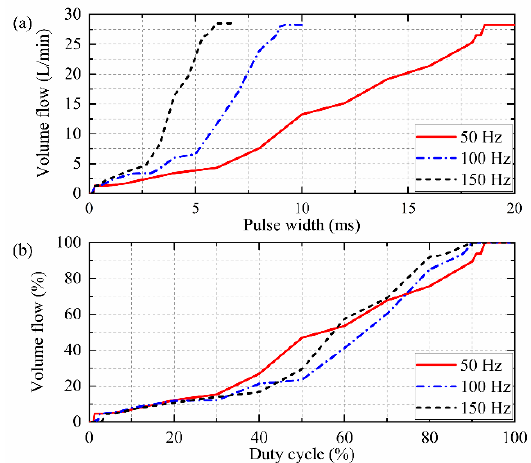
Figure 3. Standard and normalized results from 0.01 MPa pressure difference using three PWM frequencies: ( a ) Standard results; ( b ) Normalized results.